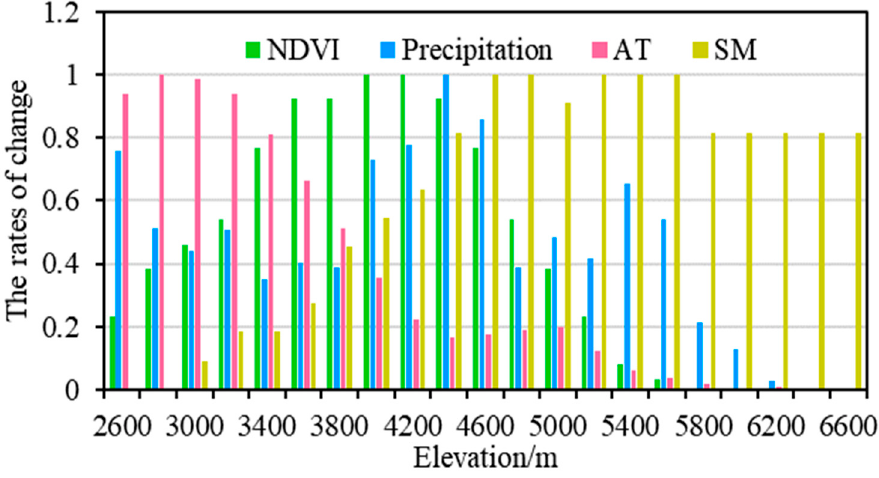
Figure 7. Changing rates of NDVI and impact factors at different elevations from 2001 to 2016.